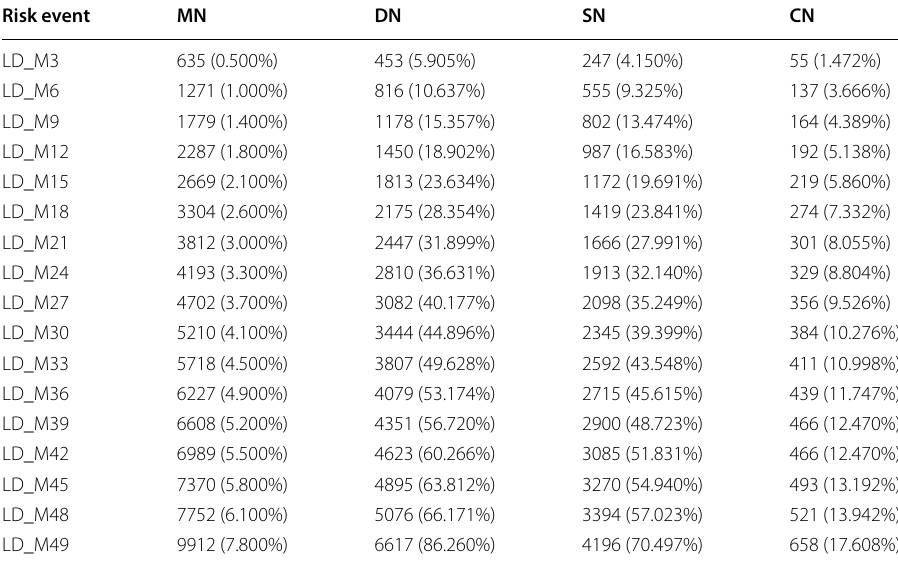
Table 17 Summary statistics of LD in different networks on NEEQ SMEs dataset Risk event